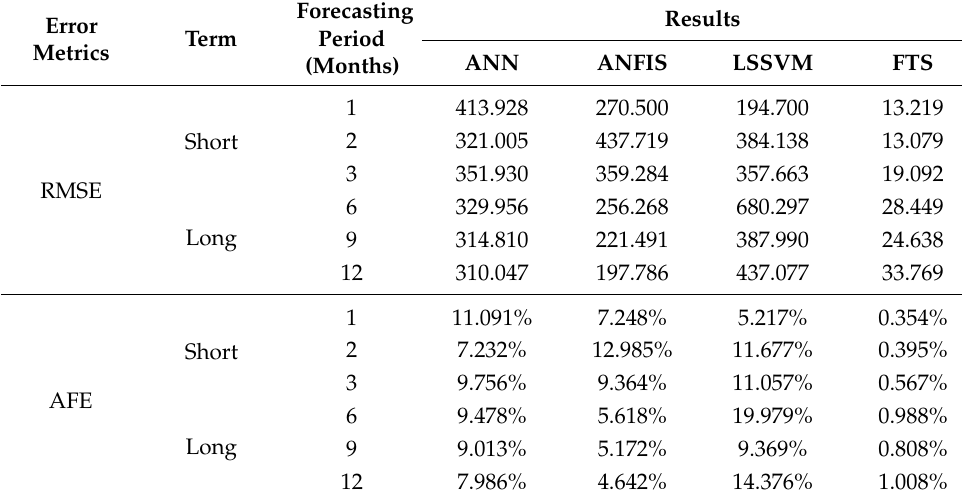
Table 10. Short-term and long-term forecasting results for Bulgaria.